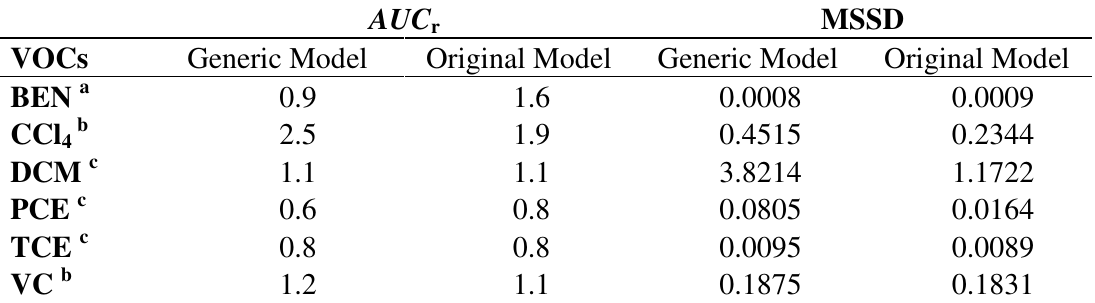
Table 1. Physiologically Based Pharmacokinetic (PBPK) volatile organic compounds (VOCs) Model